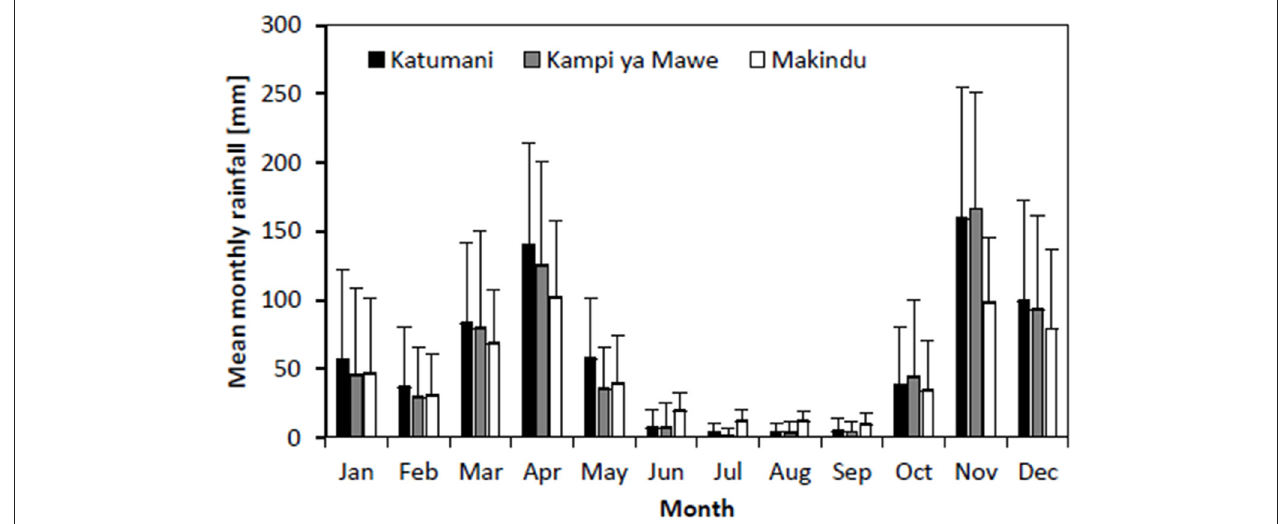
FIGURE 2 | Monthly rainfall distribution with standard deviation for Katumani (period: 1961–2013), Kampi Ya Mawe (period: 1961–2012), and Makindu (period: 1997–2014) Eastern Kenya.